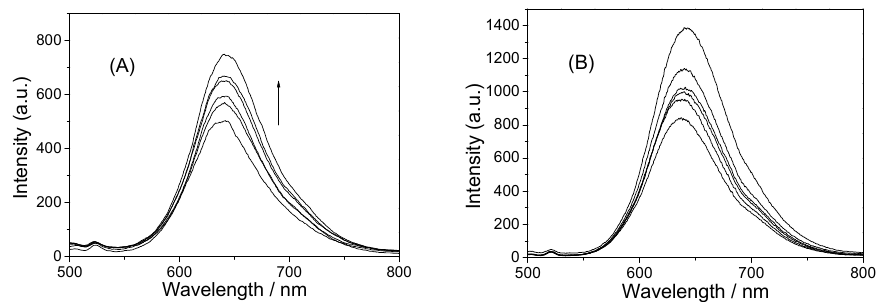
Figure 3. Luminescence spectra of 1 ( A ) and 2 ( B ) (5 μ M) after binding to CT-DNA. To further investigate the strong DNA affinity of two complexes, [Fe(CN) 6 ] 4 − was used to quench the luminescence of the complexes with or without DNA. [Fe(CN) 6 ] 4 − is a tetra-charged anion, which may bind to ruthenium complex cations via electrostatic at- traction [32]. Thiswill lead to the decrease in the luminescence of the complexes. Protec- tion of ruthenium complex cation by DNA against [Fe(CN) 6 ] 4 − will prevent luminescence quenching, which depends on the degree of protection by DNA [32]. The emission spectra of two complexes without or with DNA were collected in the range of 500 to 800 nm (Fig- ure 4). In the presence of 0–1 mM [Fe(CN) 6 ] 4 − , the luminescence intensities of the complex solutions decreased sharply. In the presence of DNA, the degree of luminescence quench- ing obviously decreased, indicating that DNA efficiently protected ruthenium complexes from [Fe(CN) 6 ] 4 − , and strong interactions existed between the two complexes and DNA.